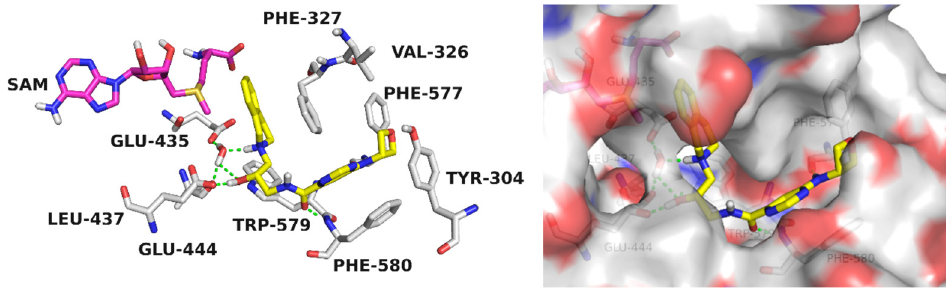
Figure 2. Crystal structure of the PRMT5 − EPZ-015666 complex (PDB code: 4X61). Protein surface is shown in gray.